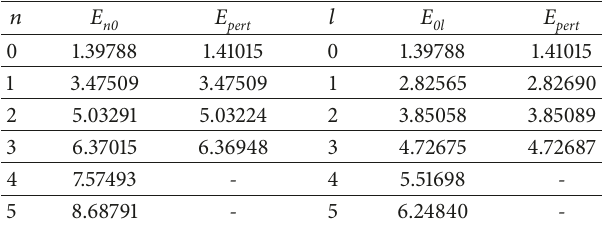
Table 2: Comparisons of the perturbative energy eigenvalues ( 𝐸 𝑝𝑒𝑟𝑡 ) (in GeV) with those obtained by direct application of AIM ( 𝐸 𝑛𝑙 ) for the potential parameters, 𝐴 = 1 and 𝐵 = 0.1 GeV, and for the reduced mass 𝜇 = 1/2 GeV.